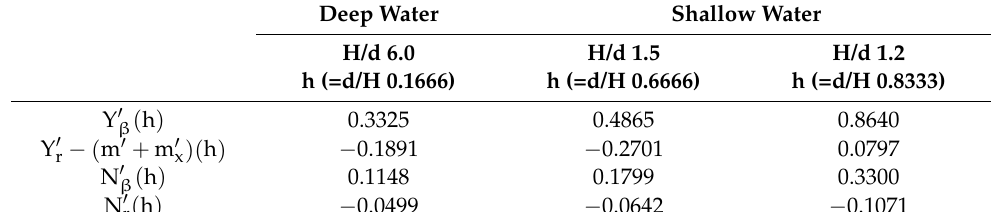
Table 8. Linear hydrodynamic coefficients by ship-draft to water-depth ratio. Deep Water Shallow Water